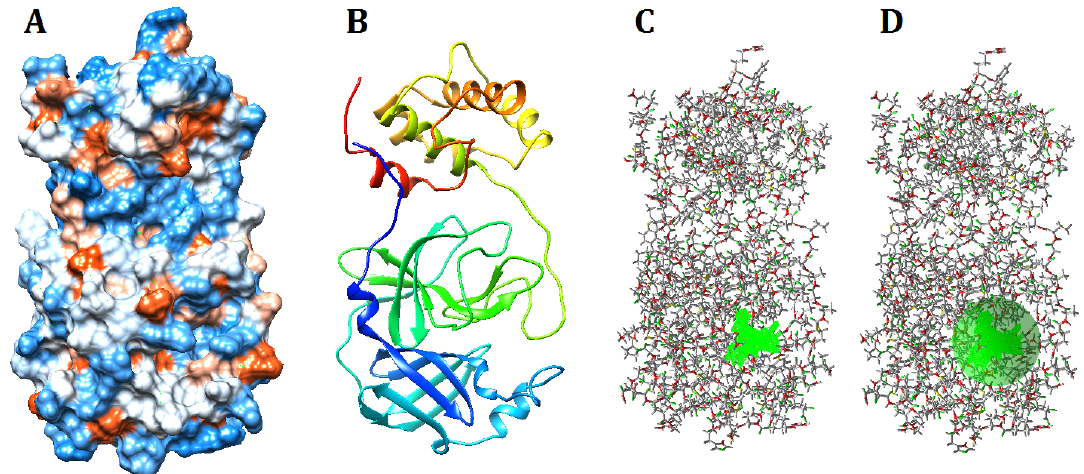
Figure 1. Visualization of SARS-CoV-2 main protease.